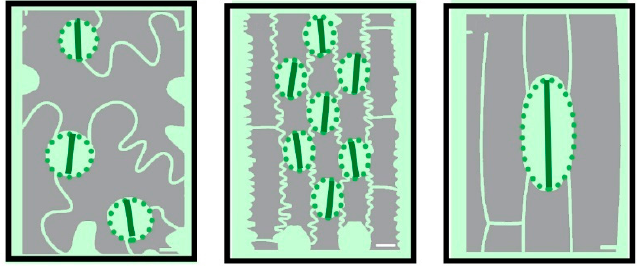
Figure 1. Some of the natural design principles as an ever-growing classification, where the last item in the list presents continuity.